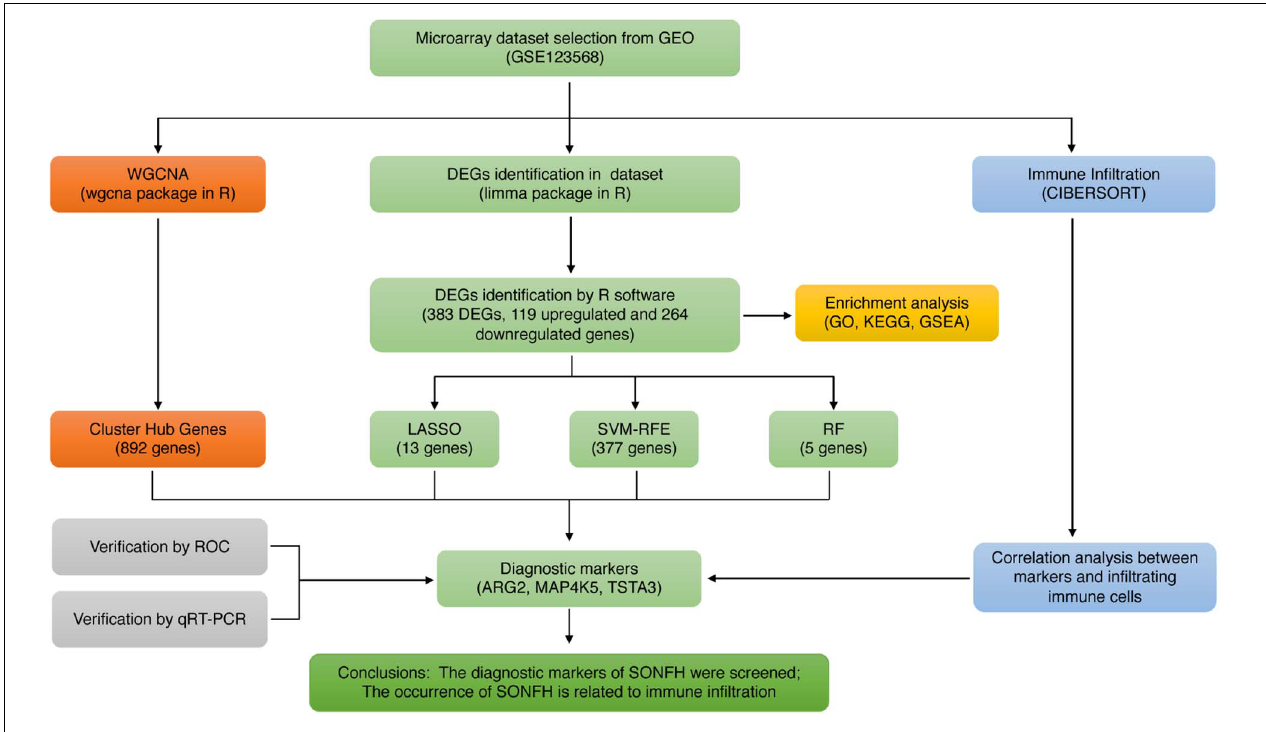
FIGURE 1 | The flowchart of the analysis process.